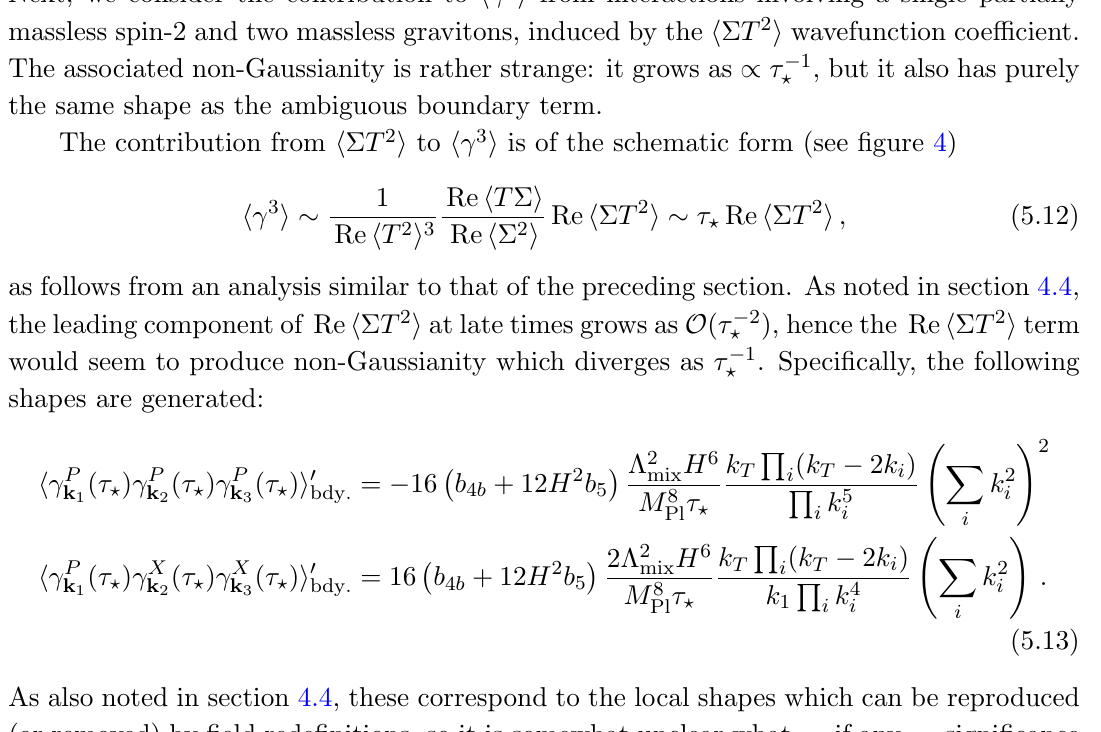
Figure 6 . The T Σ term also corrects the graviton power spectrum through diagrams of the above h i type. These corrections are small in the limit Λ mix /M Pl